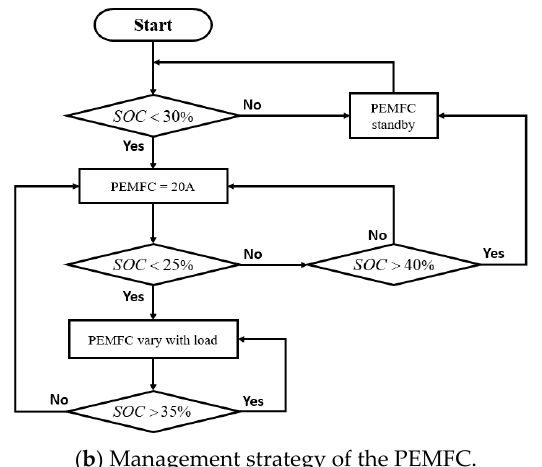
Figure 6. Flow charts of the power